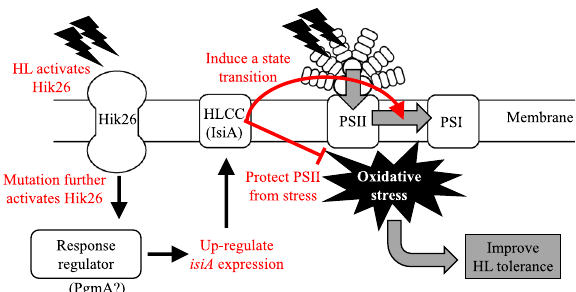
Fig. 6 A scheme of the mechanism of HL tolerance in the Tol strain. The Hik26 is a histidine kinase in response to HL stress. The mutation (T29K) of Hik26 in the Tol strain may activate the histidine kinase activity. The Hik26 induces the expression of genes including isiA through a response regulator. The IsiA contributes to protect the membrane proteins from the oxidative stress caused by HL conditions, and involves in light state transition from PSII to regulator of Hik26 would reveal the whole picture of regulatory